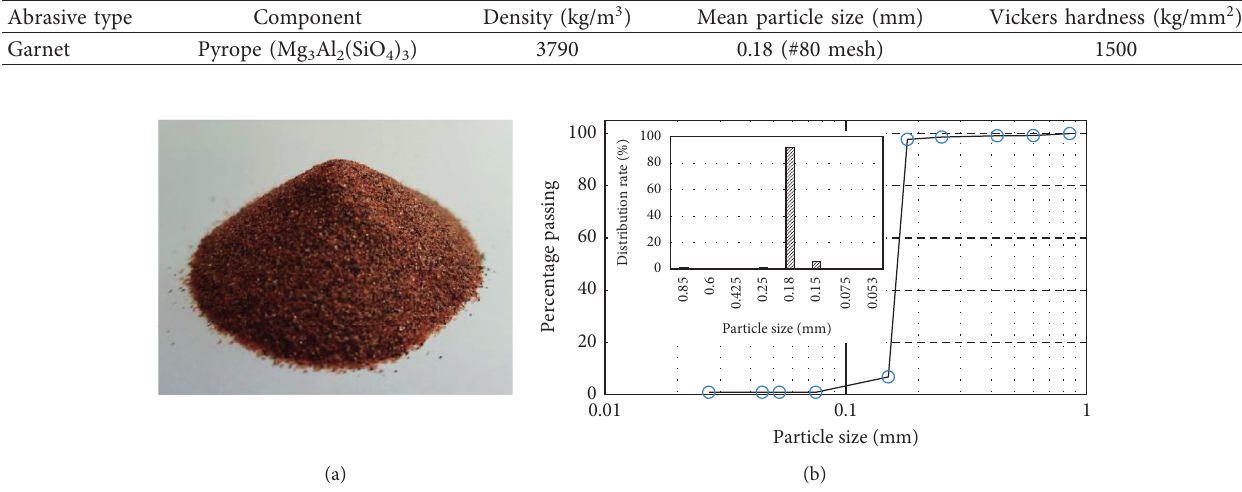
Table 2: Properties of the